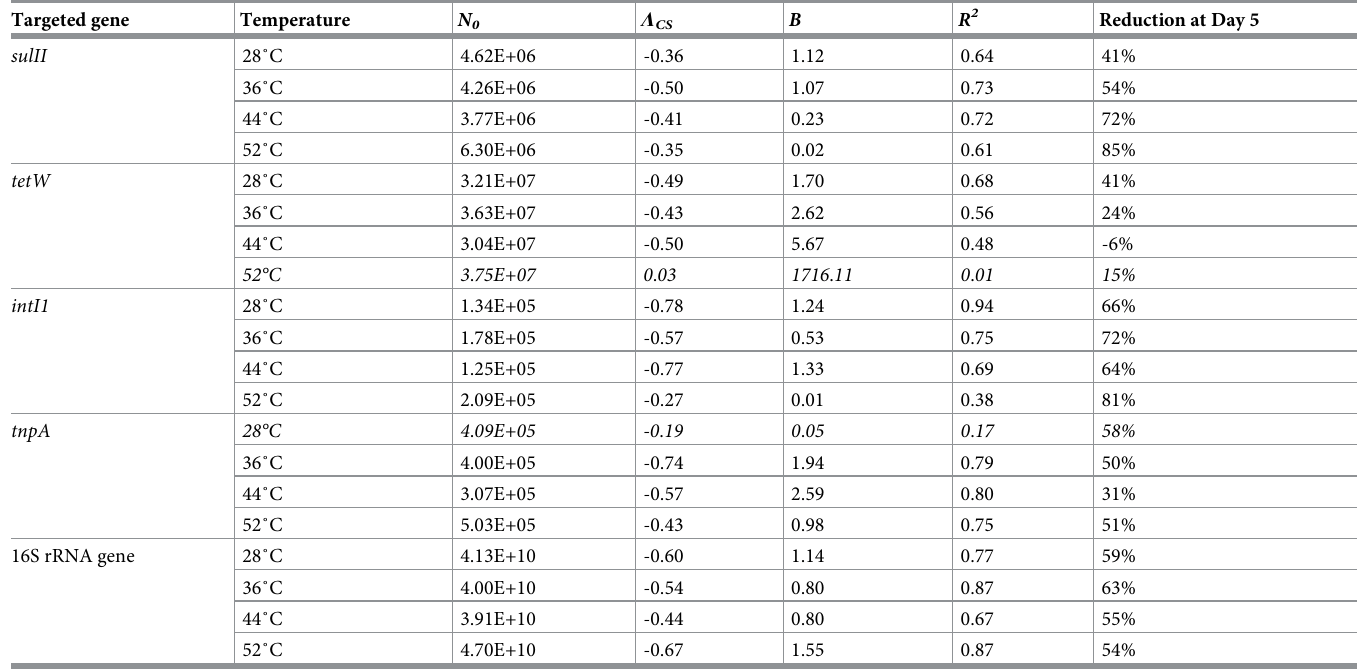
Table 2. Coefficients for modified Collins–Selleck model by least squares nonlinear regression. Targeted